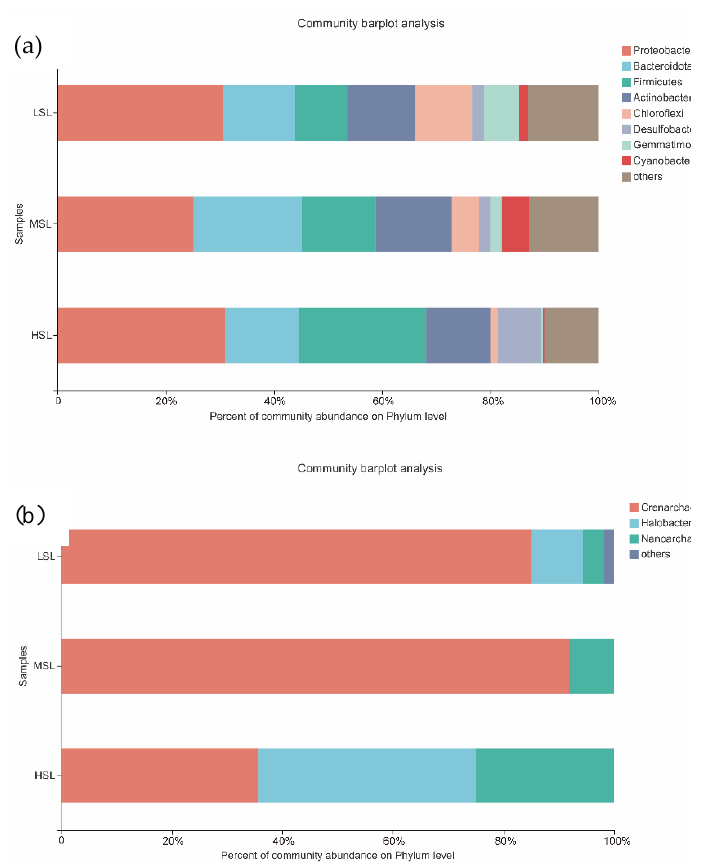
Figure 4. Composition of microbes of the sampled lakes on the Tibetan Plateau, China at phylum level: ( a ) Bacteria, ( b ) Archaea.